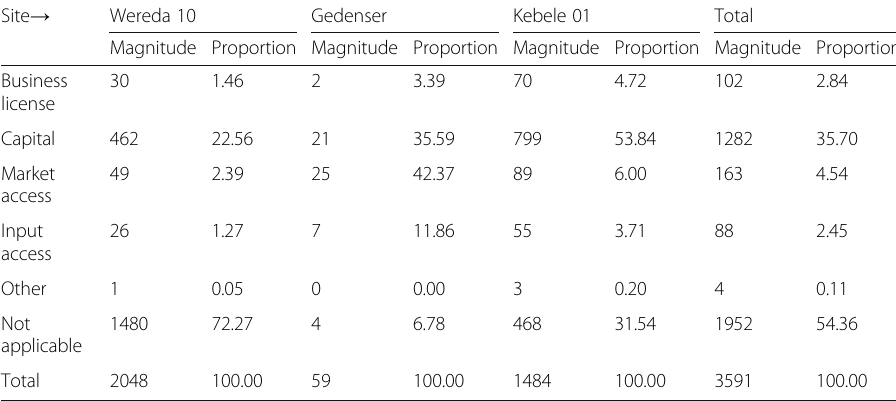
Table 2 Factors affecting to be self-employed Site